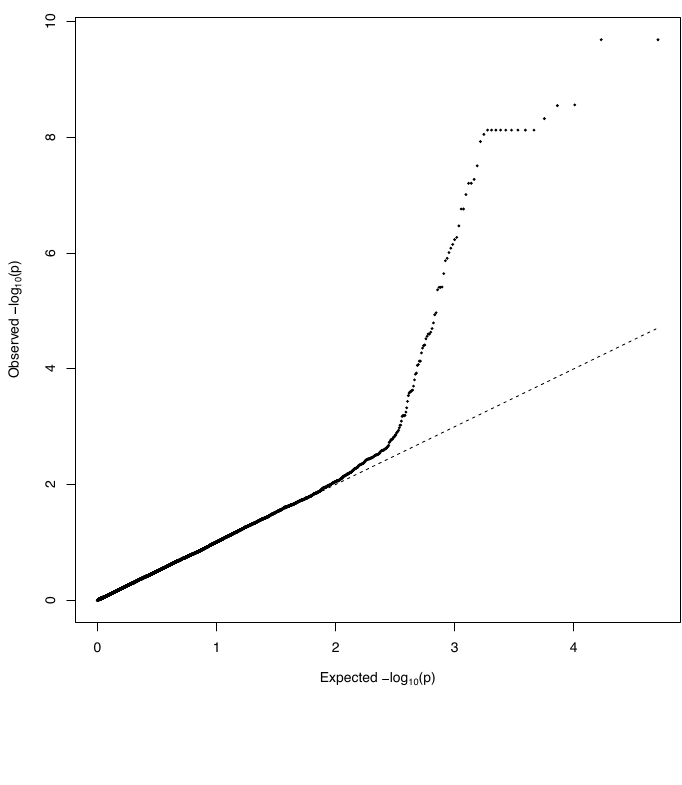
Figure 6. QQ-Plot for ‘off-the-field’ fry color in 2017